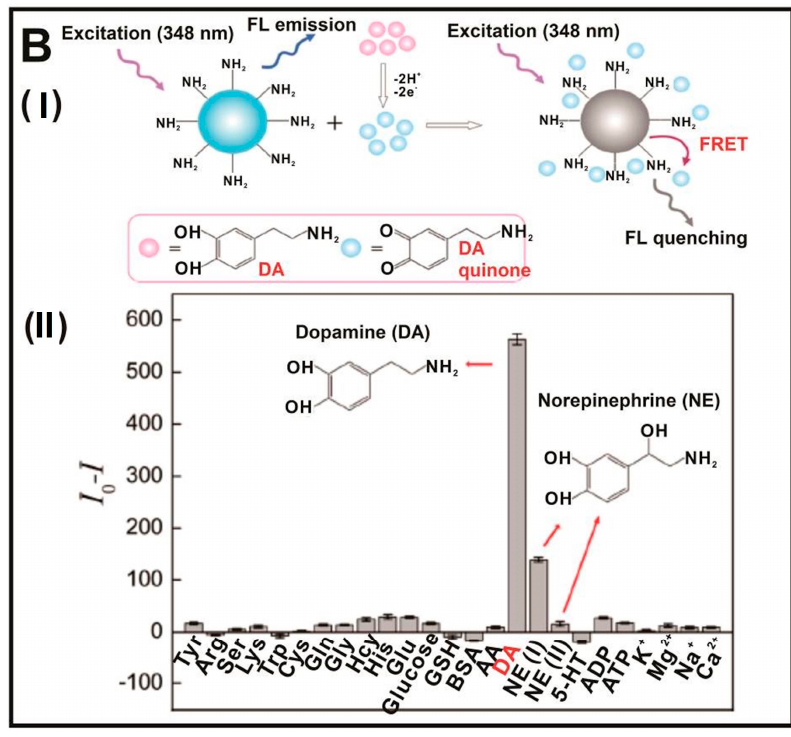
Figure 5. ( A ) Illustration of the strategy for the preparation of alkyl monomer—(top), alkyl oligomer—(middle), and alkyl amine—(bottom) capped SiQDs. Inset represents photographs of a quantum-dot filter paper, excited using a black light and with a 550 nm long-pass filter held in front of the camera. (A) Pristine paper; (B) the same paper showing a thumb imprint as a dark region. Reproduced with permission from ref. [61]. Copyright 2016, IOPscience. ( B ): ( I ) Schematic illustration of SiNP-based sensor for the detection of dopamine (DA); ( II ) selectivity of as-prepared SiNP-based sensor. Reproduced with permission from [62]. Copyright 2015, American Chemical Society.